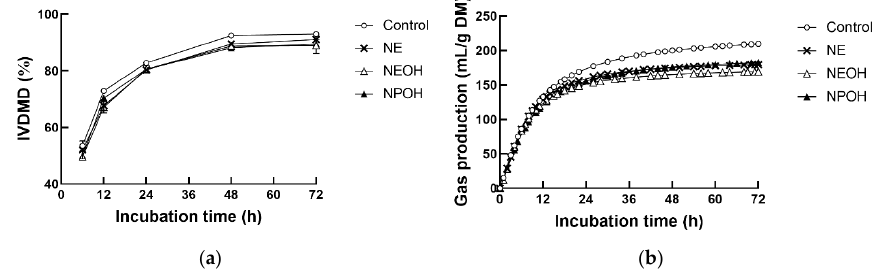
Figure 1. Effect of NE, NEOH, and NPOH addition to culture fluids on in vitro dry matter disappearance (IVDMD ( a ) and cumulative gas production ( b ) of grain-rich feed incubated with rumen fluids obtained from lactating dairy cows. NE: nitroethane; NEOH: 2-nitroalcohol; NPOH: 2-nitro-1-propanol. Statistical analyses showed that the effects of nitrocompounds on IVDMD and gas production were significant at p < 0.01.